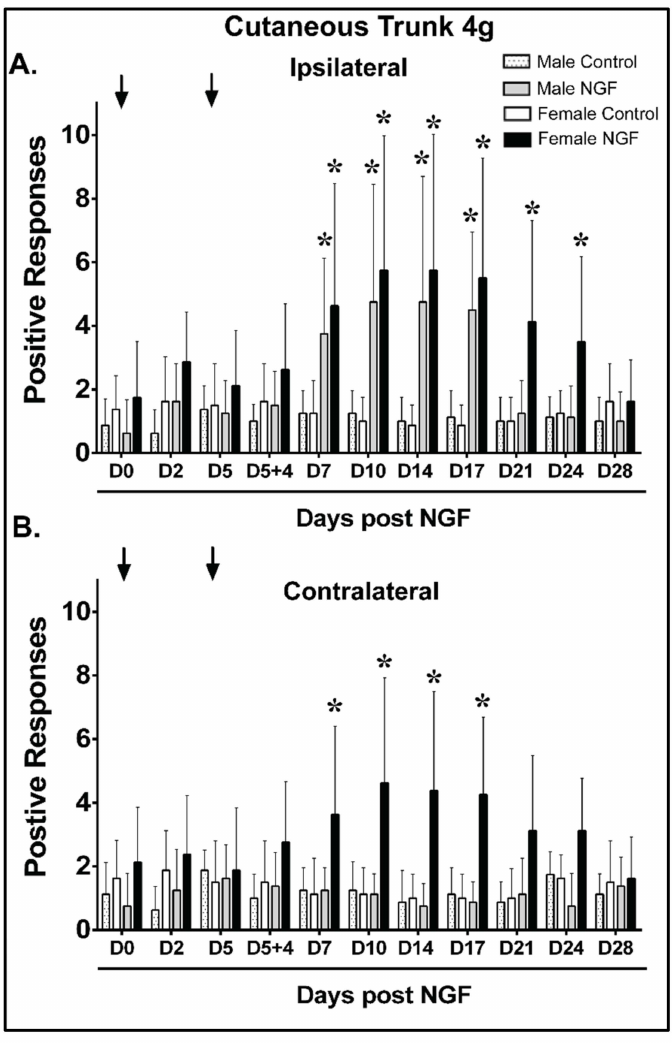
Figure 3. Females demonstrated prolonged and bilateral mechanical hypersensitivity to a 4 g cutaneous low back stimulus during persistent low back pain compared with males. ( A ) When compared to control (PBS), NGF injections (arrows, 0.8 µ M) resulted in ipsilateral low back mechanical hypersensitivity with increased mean positive responses to a cutaneous 4 g filament stimulus from D7 to D17 in male rats and from D7 to D24 in female rats compared to baseline (D0). ( B ) NGF injections were also associated with contralateral low back mechanical hypersensitivity with increased mean positive response to a cutaneous 4 g filament stimulus at D7, D10, D14, and D17 in female rats compared to baseline (D0). No significant changes were noted in males compared to baseline at any time point. No significant differences were detected at D0 when comparing all groups ( A , B ). Data are reported as means ± SD and analyzed by two-way ANOVA with Bonferroni’s comparisons to baseline within a group or two-way ANOVA with Tukey’s multiple comparisons between groups for n = 8/group. * p < 0.01 vs. D0 prior to